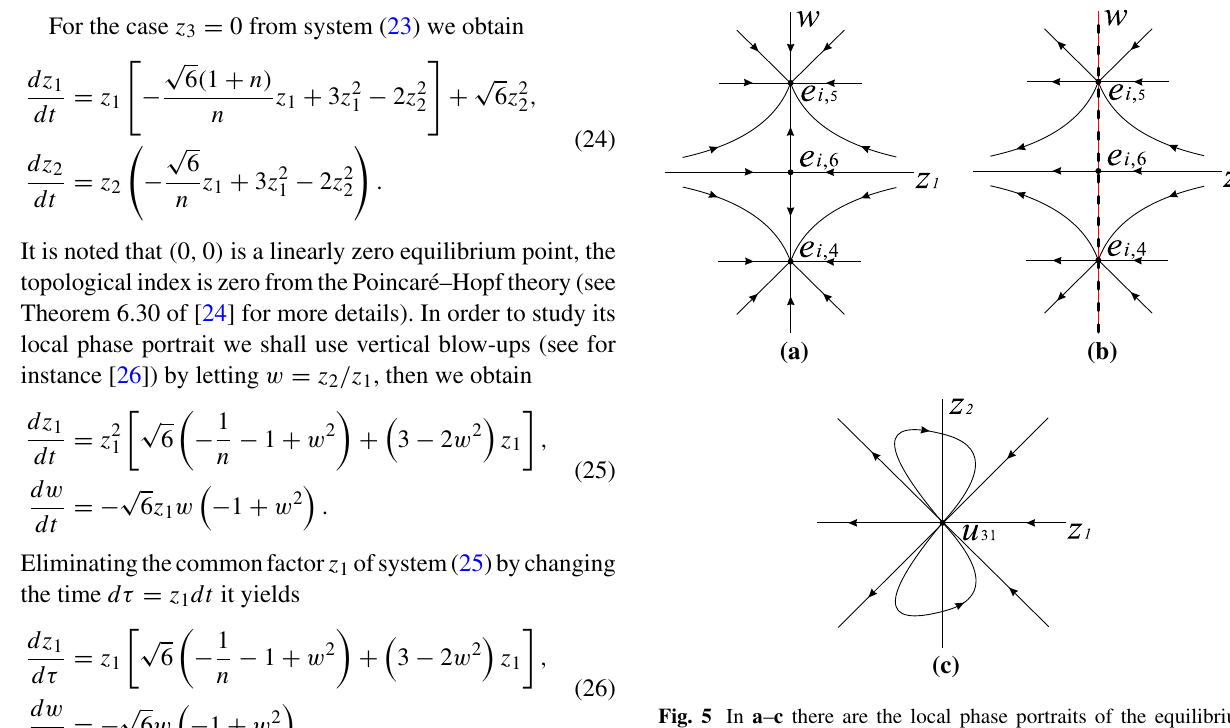
Fig. 5 In a – c there are the local phase portraits of the equilibrium points in systems (26), (25) and (24), respectively